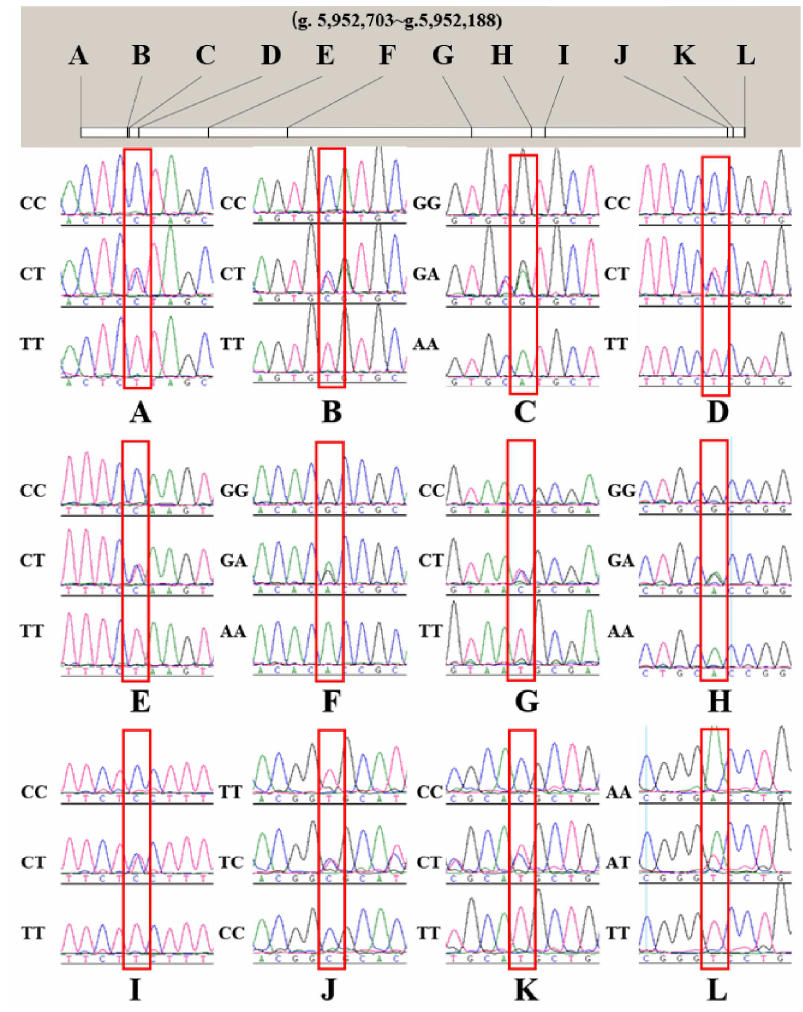
Figure 3. The peak maps of all genotypes of the SNPs. ( A ): g.5,952,703 C > T; ( B ) g.5,952,667 C > T.